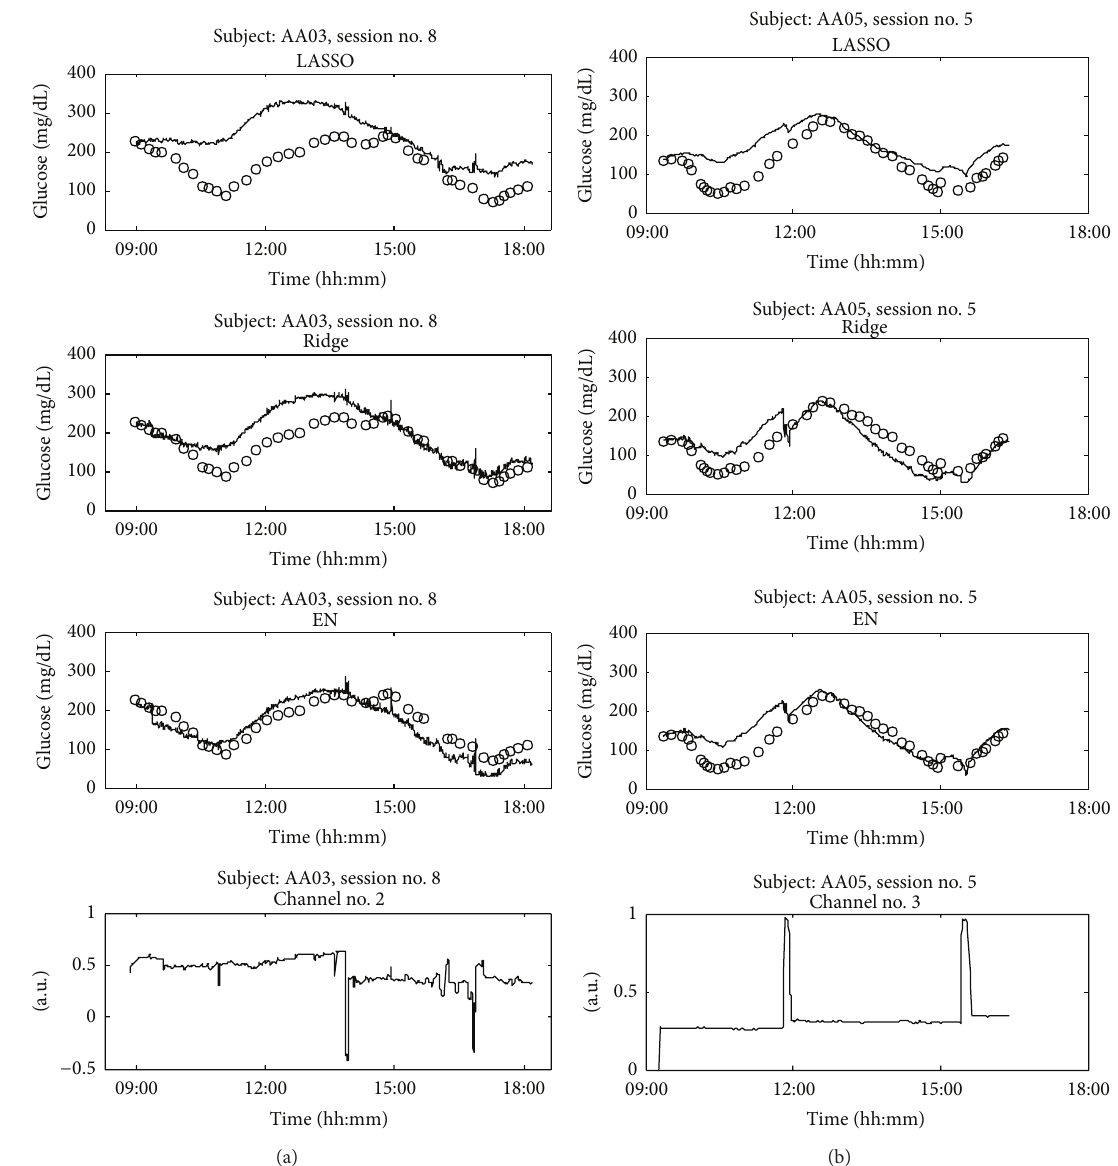
Figure 4: Representative recording sessions of Subjects AA03 (a) and AA05 (b). LASSO, Ridge, and EN models test over independent test data subset (continuous lines) versus RBG levels (open bullets). Bottom panels display two representative channels (no.2 and no.3 for subject on the left and on the right, resp.) entering the models, where occasional spikes and jumps are evident. MARD values for the experimental session on the right are of 53% (LASSO), 24.5% (Ridge), and 20.6% (EN), while for the experimental session on the left of 55.7% (LASSO), 34.8% (Ridge), and 34.7%